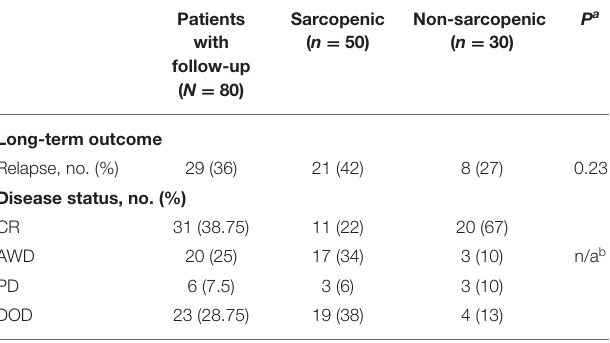
TABLE 2 | Comparison of long-term post-operative outcome with sarcopenic status in patients with follow-up.